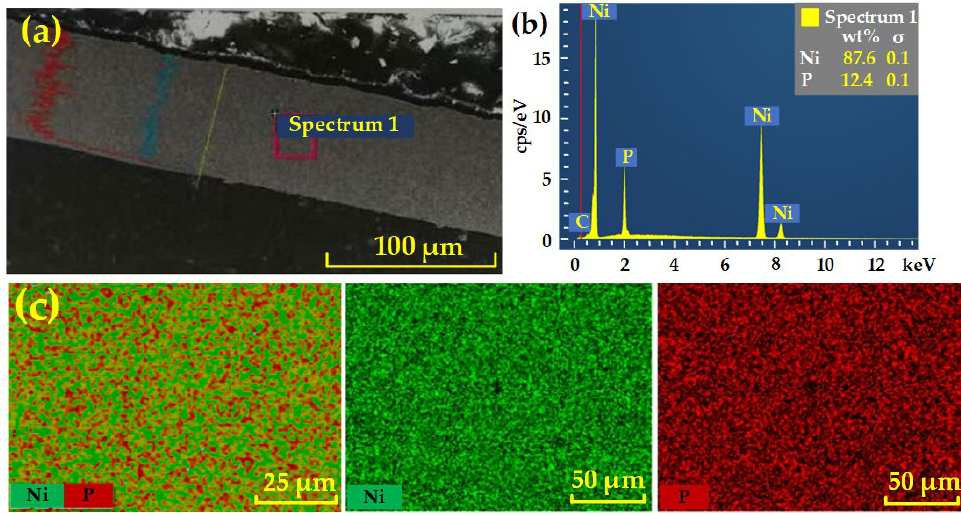
Figure 1. Test results of the experimental sample. ( a ) Cross-sectional morphology of the NiP coating, ( b ) Elemental analysis result, and ( c ) EDS mapping.